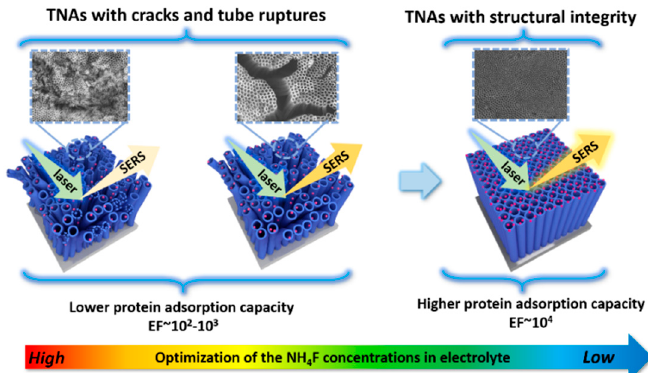
Figure 9. Schematic representation of SERS from Cyt c adsorbed on TiO 2 nanotube arrays with different structural integrities through optimization of the topography. Reprinted from Ref. [113] with permission from American Chemistry Society.